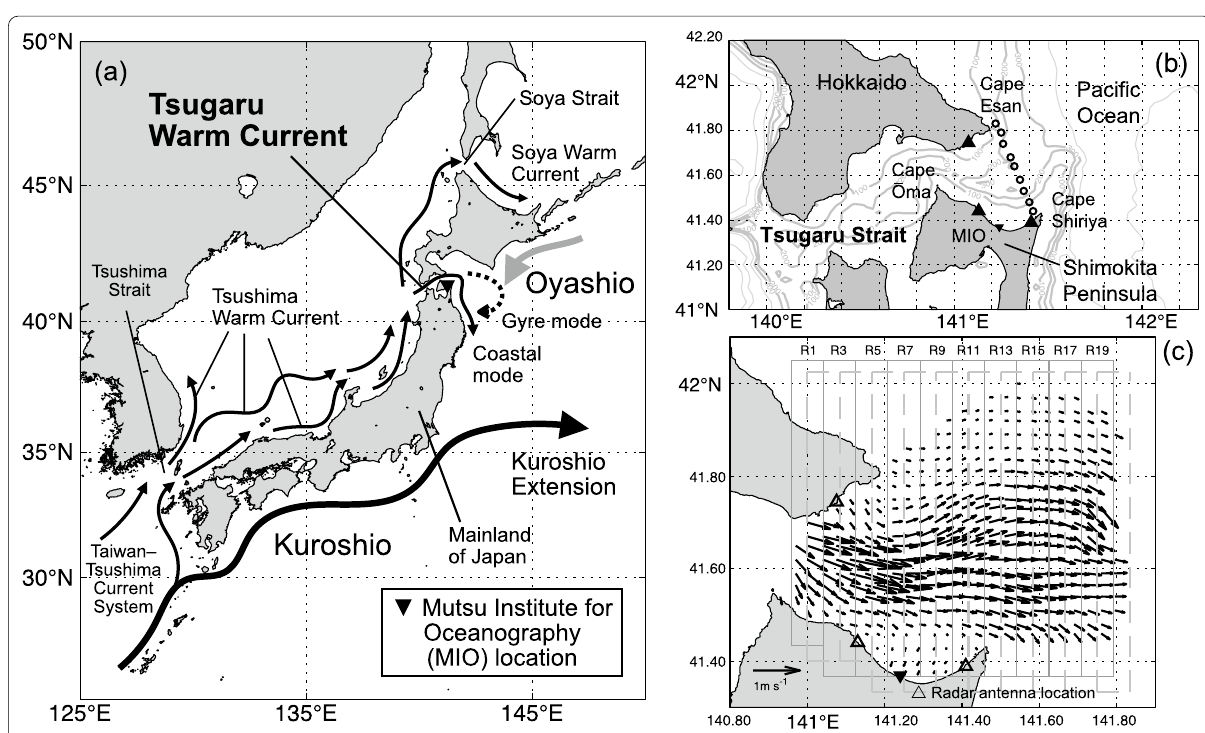
Fig. 1 a Schematic diagram of the flows around Japan. b Locations of stations along the repeated observation lines in the Tsugaru Strait. c Observation site of the present study and distribution of the temporal mean velocity at each grid point for 2017–2019. The contours in b denote bathymetry. The rectangle in c indicates the subregions (R1 to R20) used to calculate the zonal average of the zonal